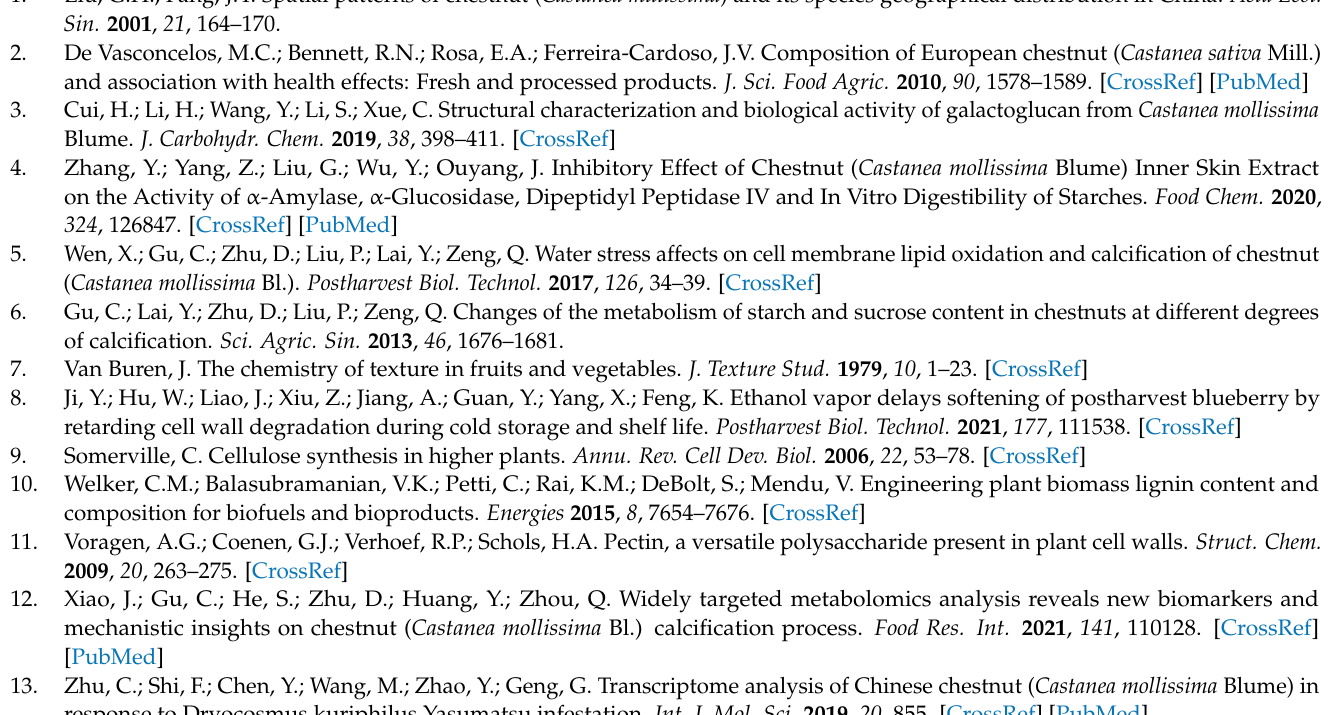
Table S4: KEGG enrichment analysis of differentially expressed genes (DEGs). Table S5: GSEA of all differential genes based on the 64 significantly enriched gene ontology (GO) terms; Table S6: List of qRT-PCR primer sequences